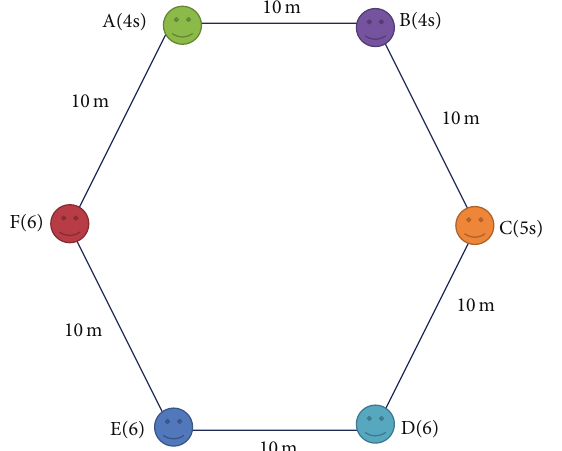
Figure 4: Positions and iPhone version of six residents.